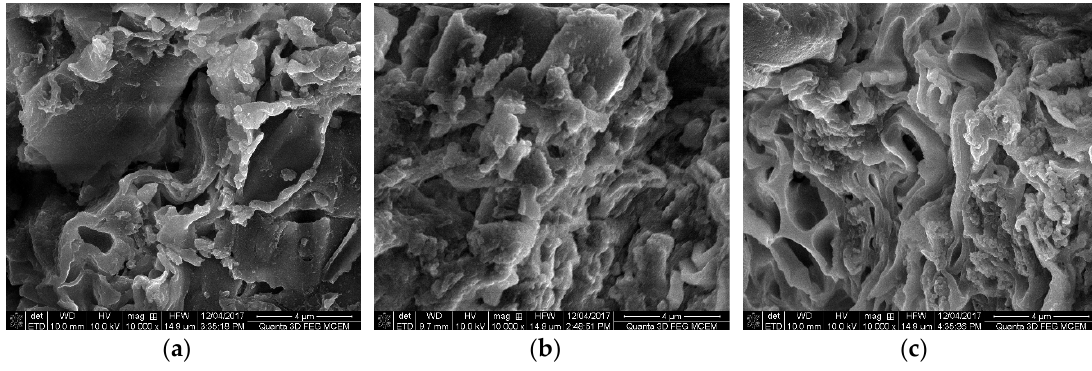
Figure 5. SEM images of ( a ) 5%, ( b ) 15% and ( c ) 25% brine-saturated samples (Images taken under accelerated voltage of 10 kV, with 47 pA probe current and magnification of 10,000×; more flaky textures and pores are presented in these images due to the corrosion of brine solution).